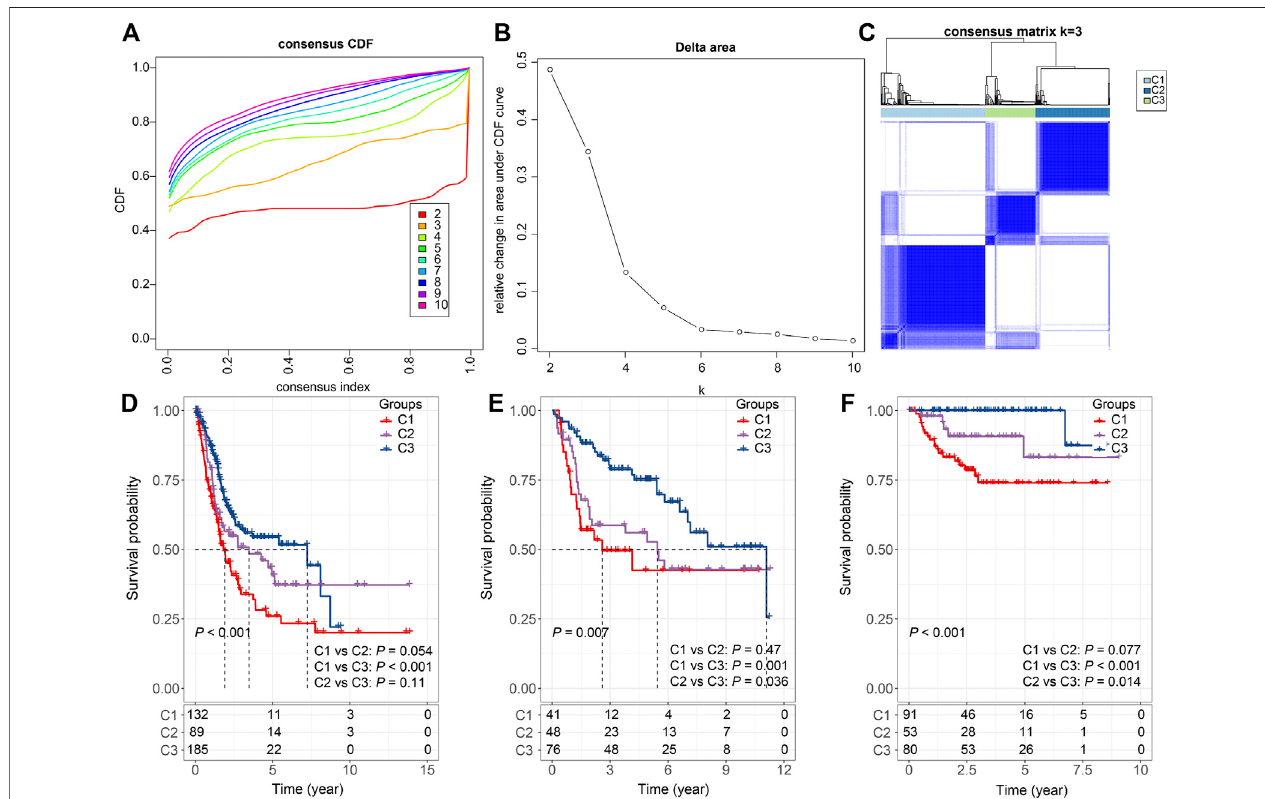
FIGURE 2 | Consensus clustering based on LR pairs (A) . CDF curvesof consensus clustering ofthe TCGAcohort (B) . Delta area curve ofconsensus clustering of the TCGA cohort. (C) Consensus matrices of identi fi ed clusters (k = 3) (D) . Kaplan – Meier curve of the overall survival across the three subtypes in the TCGA cohort ( p < 0.001;C1vs.C2: p =0.054;C1vs.C3: p < 0.001;C2vs.C3: p =0.11). (E) .Kaplan – MeiercurveoftheoverallsurvivalacrossthethreesubtypesintheGSE13507cohort ( p = 0.007; C1 vs. C2: p = 0.47; C1 vs. C3: p = 0.001; C2 vs. C3: p = 0.036). (F) . Kaplan – Meier curve of the overall survival across the three subtypes in the GSE32894 cohort ( p = 0.007; C1 vs. C2: p = 0.077; C1 vs. C3: p < 0.001; C2 vs. C3: p = 0.014).